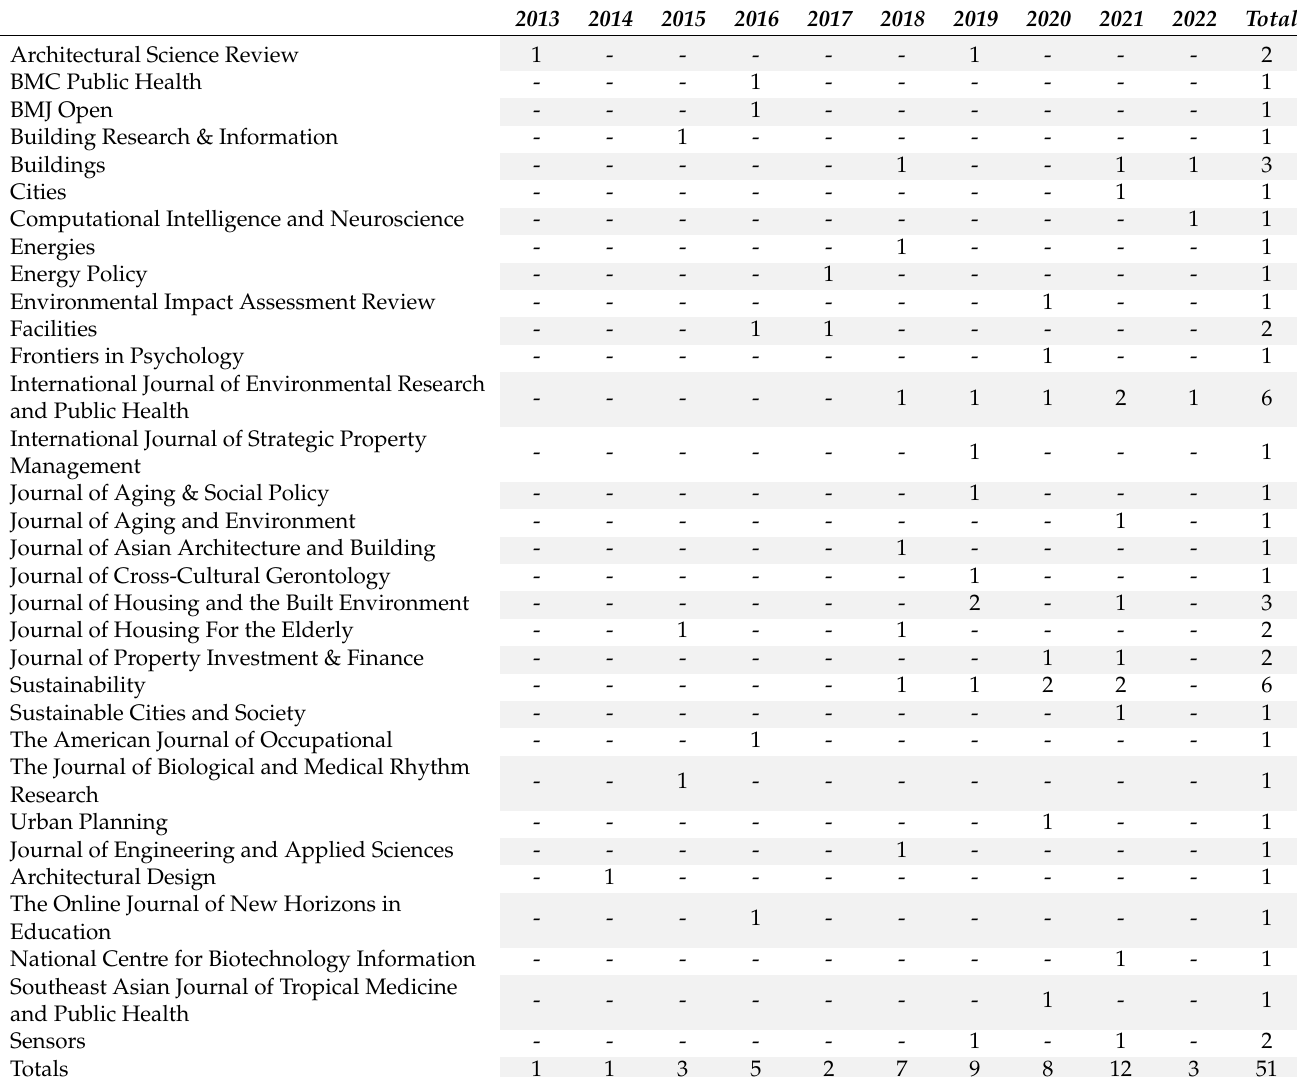
Table 3. Number of articles according to periodicals and papers reviewed by